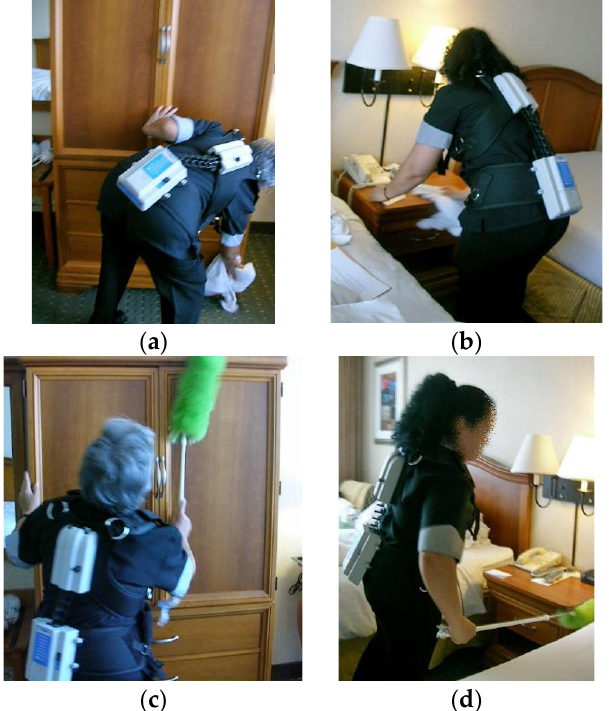
Figure 3. Dusting tasks studied. Dusting an armoire and nightstand using standard methods are shown in ( a , b ); those tasks done using a long-handled, extendable tool are shown in ( c , d ).